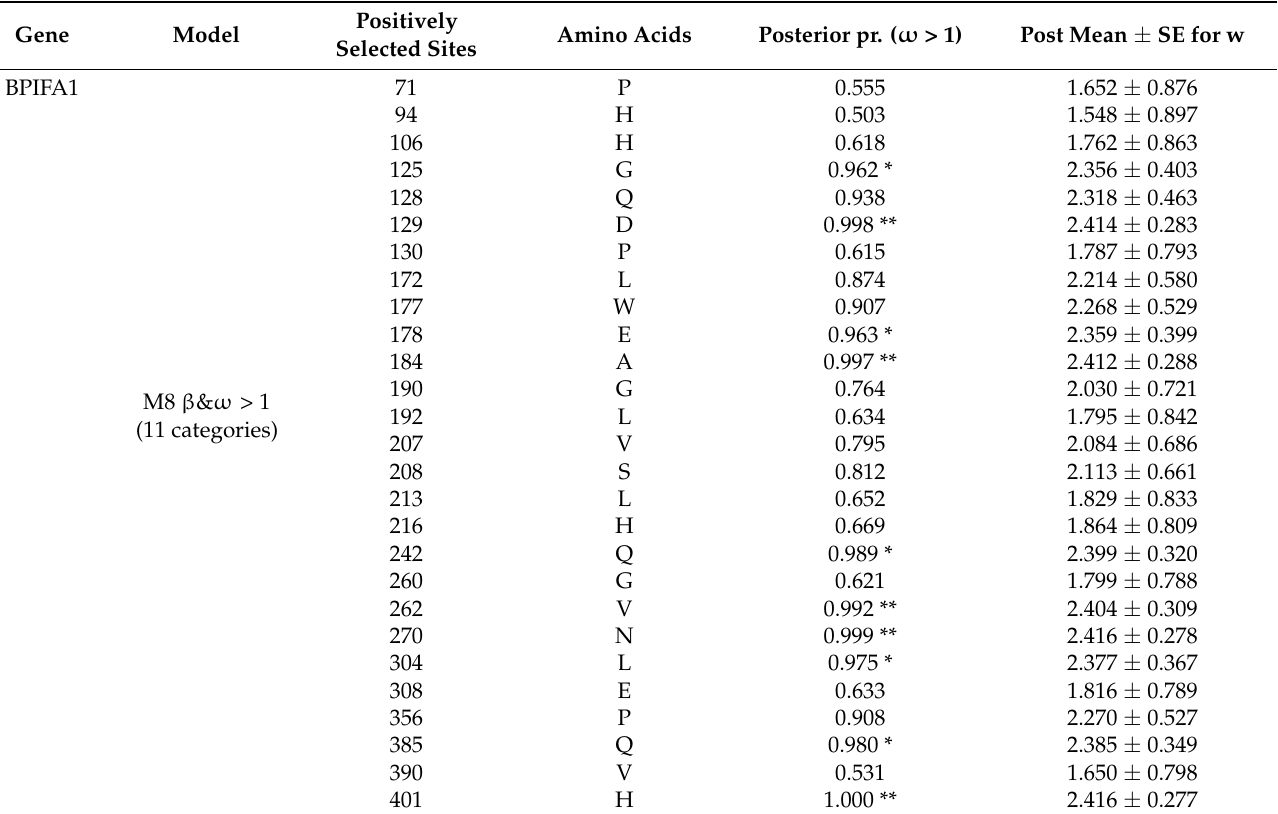
Table 2. Positively selected locations under the PAML model are discovered using Bayes empirical Bayes (BEB)